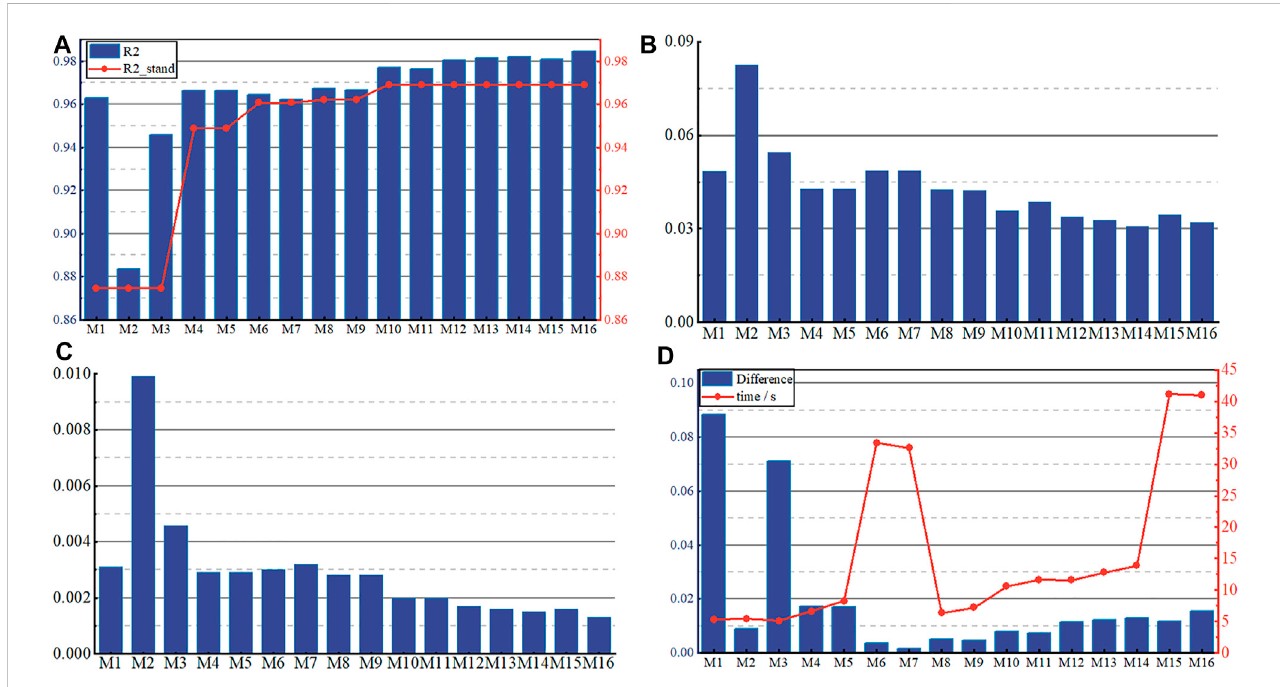
FIGURE 8 Indicatorsforthe16IN-Votingmodels (A) R 2 andthedistributionofmaximum R 2 ineachcombination; (B) ThedistributionofMSE; (C) Thedistributionof MAE; (D) Difference values and optimization time.